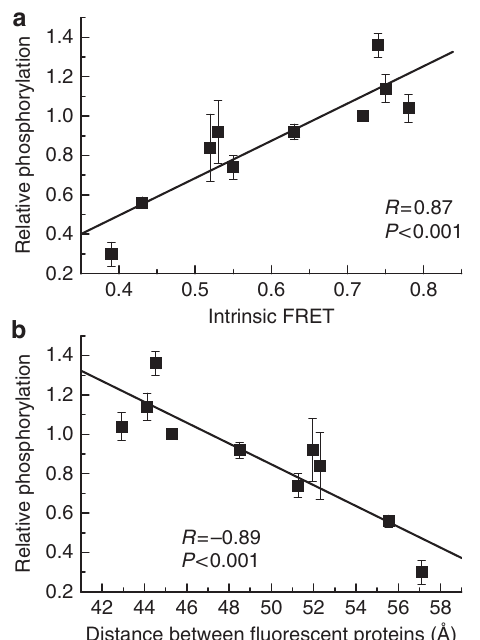
Figure 7 | Correlation between intrinsic FRET and phosphorylation. Results are shown for wild-type FGFR3 and the three studied FGFR3 mutants: the L377I-G380I-A391I mutant, the A374I-G375I-S378I mutant, and the A391E mutant, when 100% dimeric (see text). At least three independent experiments were performed for each mutant. The phosphorylation of the wild type in the fgf2-bound state is assigned a value of 1, and all other measured phosphorylation levels are scaled accordingly. ( a ) There is a strong correlation between the measured intrinsic FRET and phosphorylation ( P o 0.001). ( b ) Strong correlation between the distance between fluorescent proteins in the EC þ TM FGFR3 constructs and full- length FGFR3 phosphorylation. state. This is a fundamentally novel mechanism through which FGFR-linked pathologies can arise.